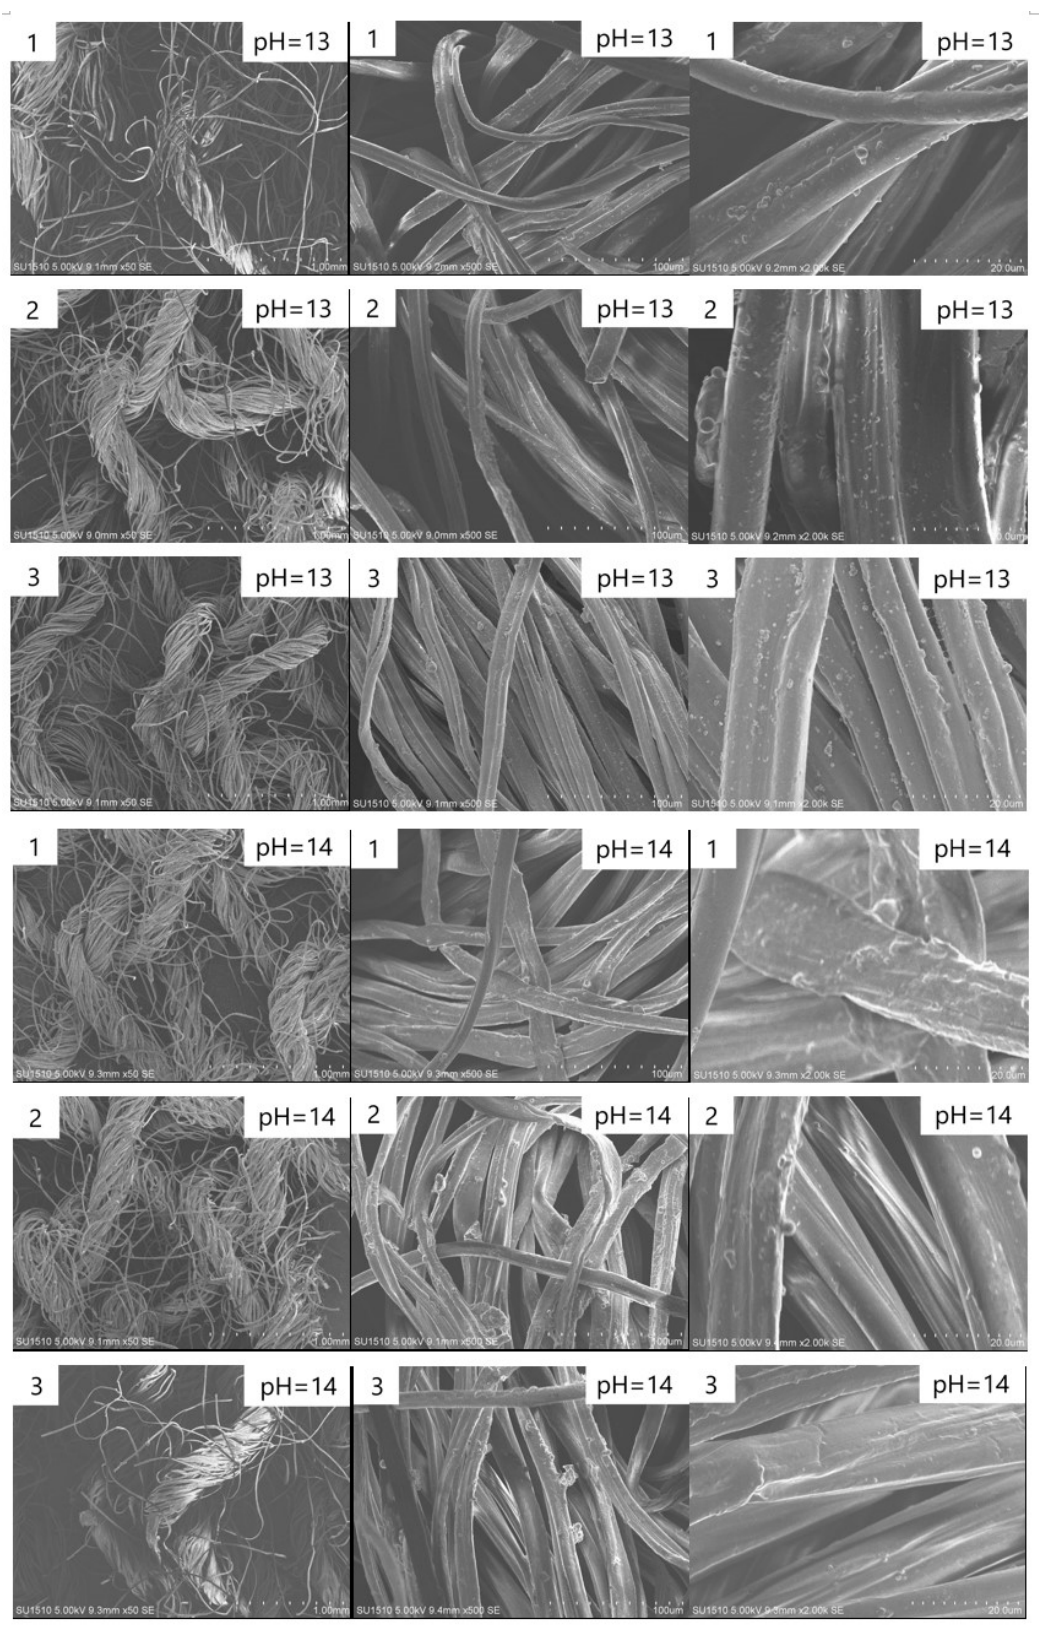
Figure 7. SEM images of three fabrics treated in acid solution, ultrapure water, and aqueous alkali for half an hour.